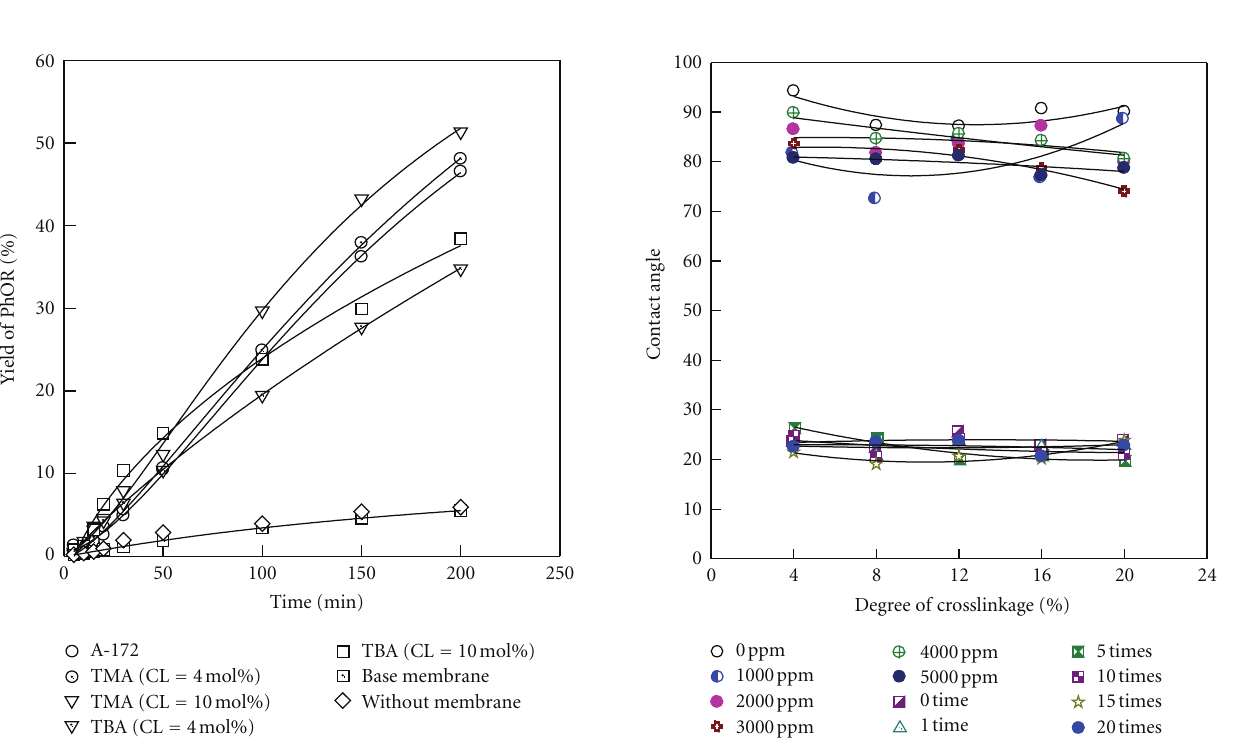
Figure 5: PhOR yield from various membranes with an excess of organic reactant. 45 ◦ C, 400rpm. Aqueous phase (55cm 3 ): 0.004 mol of phenol, NaOH = 0.0064 mol. Organic phase (55cm 3 ): 1,2-C 2 H 4 Cl 2 , 0.06 mol of C 3 H 5 Br. Data quoted from Wu and Lo [12].